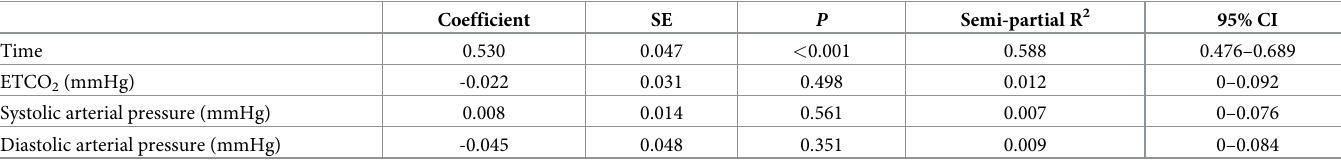
Table 5. Fixed effects of time, systolic arterial pressure, diastolic arterial pressure, and ETCO 2 level on LV wall thickness in mixed effect model including all these hemodynamic parameters.